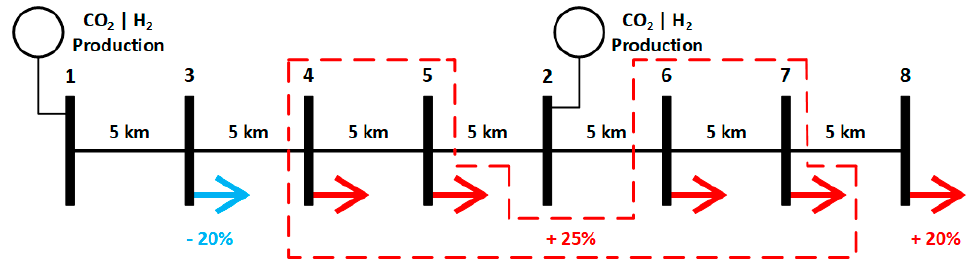
Figure 3. Pipeline network with the detailing of production and consumption behaviour.